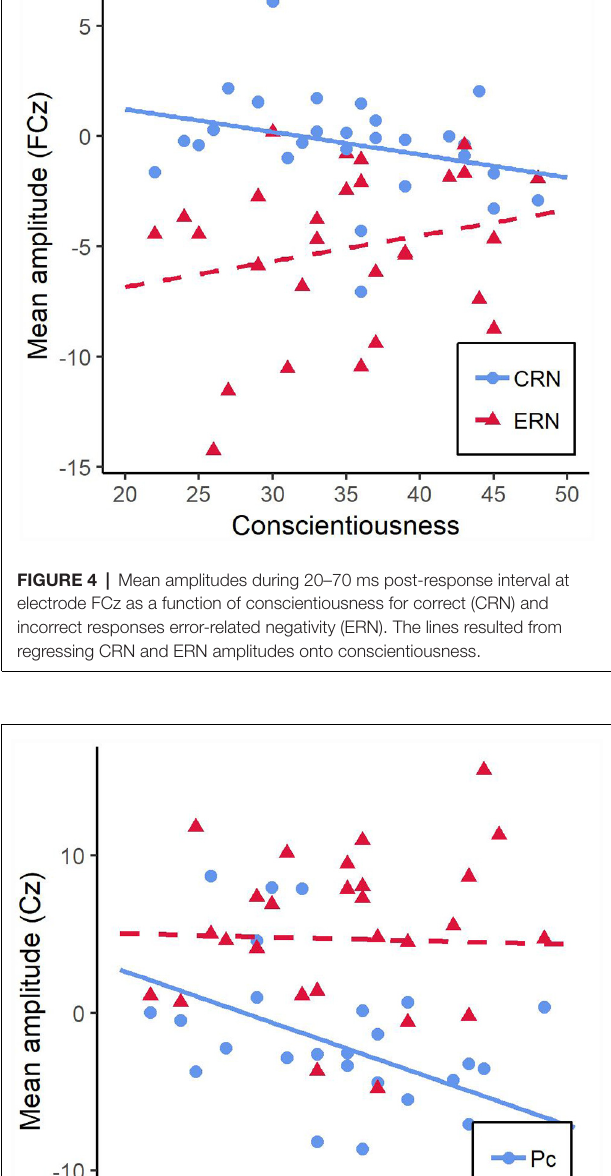
amplitude with a larger dataset including participants that were sorted out before due to insufficient numbers of